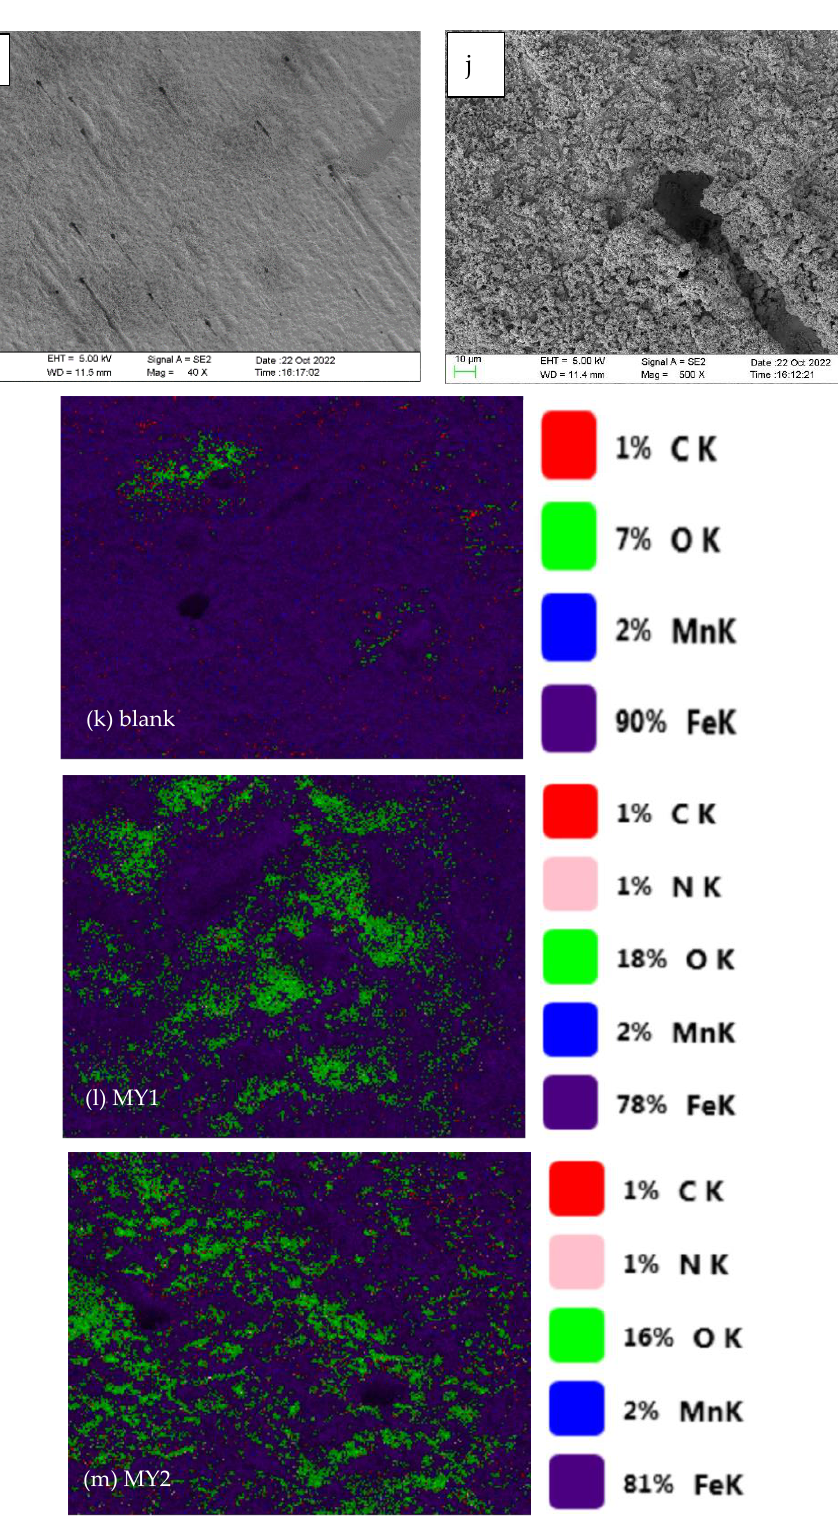
Figure 6. SEM images in 15% HCl solution containing different concentrations of inhibitor and EDS elemental mapping images with 0.7% inhibitor concentration. ( a ) SEM of blank (40×); ( b ) SEM of blank(500×); ( c ) SEM of 0.3%MY1(40×); ( d ) SEM of 0.3%MY1(500×); ( e ) SEM of 0.3%MY2(40×); ( f ) SEM of 0.3%MY2(500×); ( g ) SEM of 0.7%MY1(40×); ( h ) SEM of 0.7%MY1(500×); ( i ) SEM of 0.7%MY2(40×); ( j ) SEM of 0.7%MY2(500×); ( k ) EDS elemental mapping of blank; ( l ) EDS elemental mapping of 0.7%MY1; ( m ) EDS elemental mapping of 0.7%MY2.